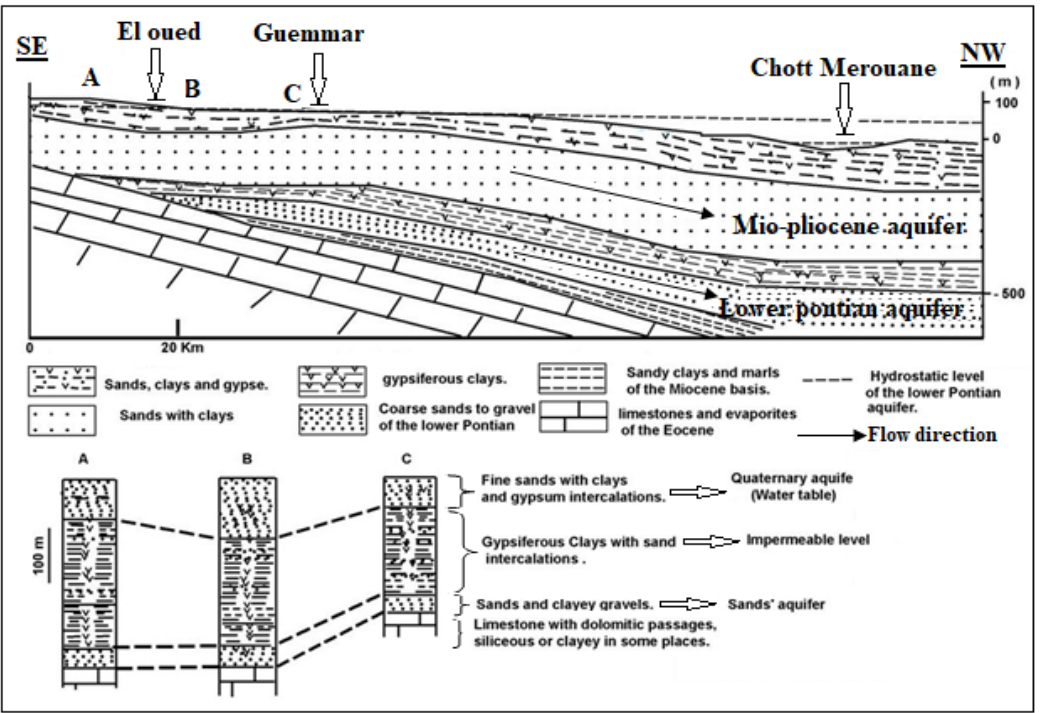
Figure 2. Top: Hydrogeological cross-section of Oued souf valley, bottom: ( A–C ) are log correlation of Oued souf valley modified from [15].